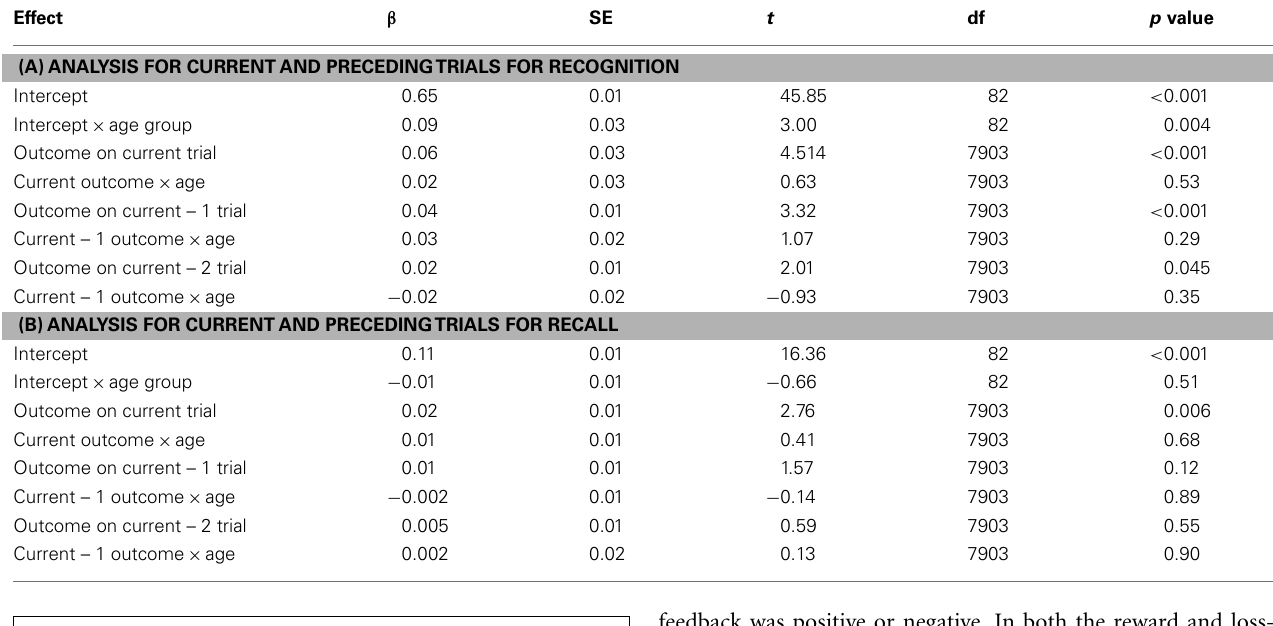
Table 1 | Hierarchical linear model (HLM) analysis beta coefficients ( β ), robust standard errors (SE), t ratios ( t ), degrees of freedom (df), and p values using the outcome on the current and preceding two trials to predict recognition (A) and recall (B) of the current trial’s target picture.